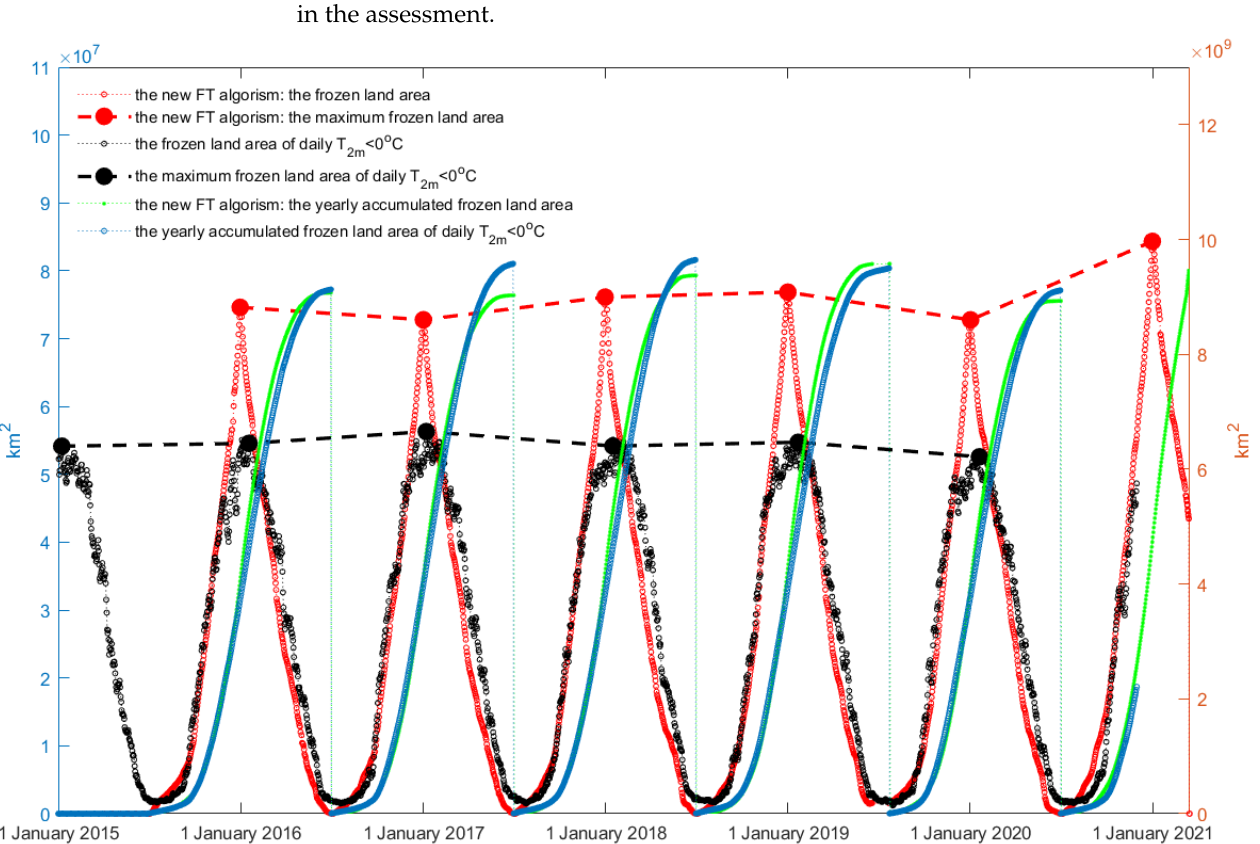
Figure 13. The cover of the frozen land detected by the new FT algorithm and